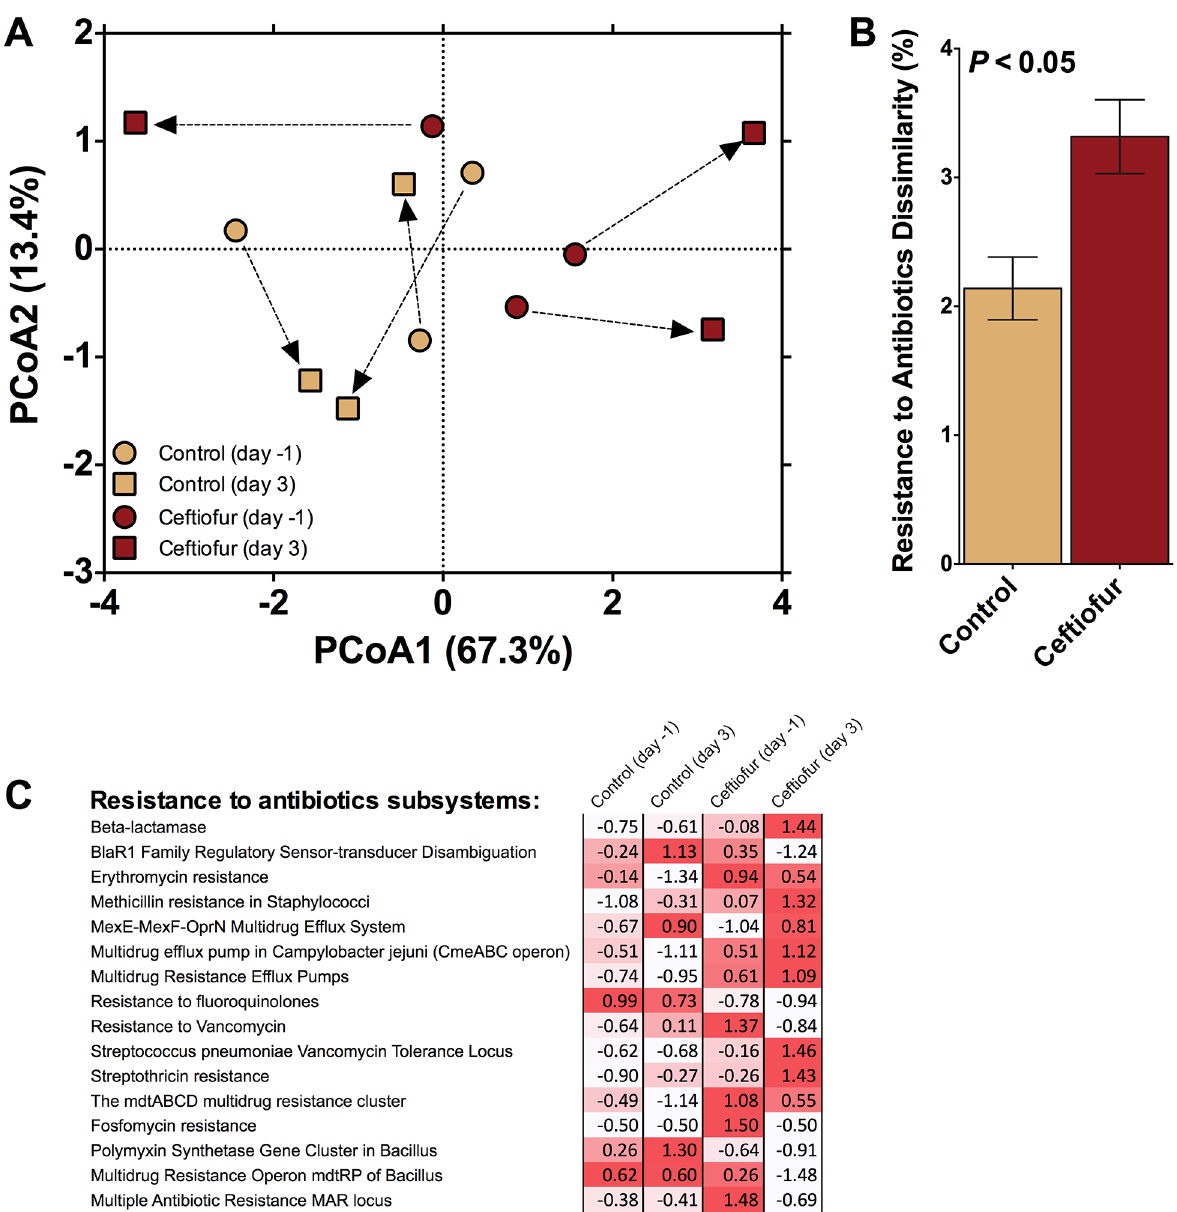
Fig 6. Sequences related to antibiotic resistance found in the 'Resistance to antibiotics and toxic compounds' subsystem. A) Principal component analysis illustrating Bray-Curtis distance between initial sequences related to antibiotic resistance and those after 3 days of either exposure or no exposure to the antibiotic ceftiofur. Arrows indicate the change in communities associated with individual cows. B) Dissimilarity after 3 days between the fecal derived subsystems of control and ceftiofur-treated cows. C) Standard scores (i.e. z-scores) compared across treatments within a given subsystem. Red intensity of Z-scores indicates relative increase from the mean associated with that